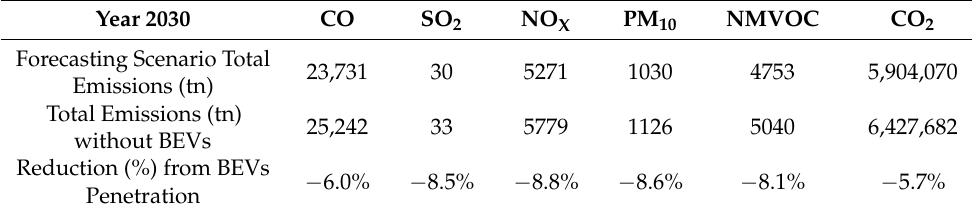
Table 2. Emissions reductions owing to BEVs penetration in